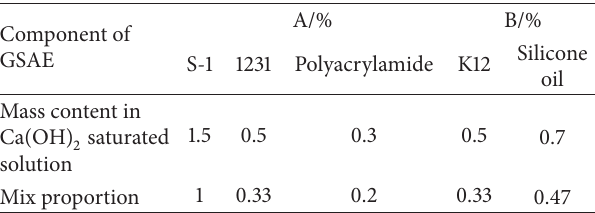
Figure 10: The effect of K12 against 1231 and silicone oil against mother solution. Table 1: Mix proportion of